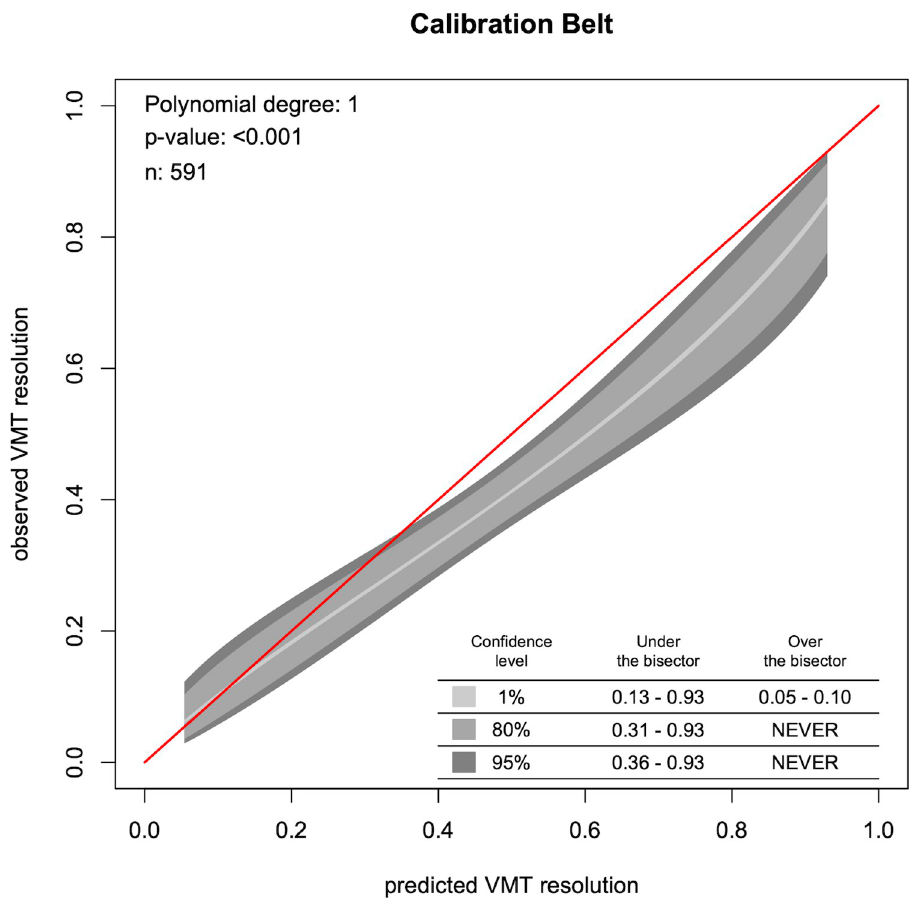
Fig 2. Calibration belt of the predicted VMT resolution by the EXPORT model and the observed VMT resolution in the current pooled patient cohort. The red line depicts a theoretical perfect correlation. The calibration belt is plotted in grey, consisting of the 95% (dark grey), 80% (grey) and 1% (light grey) confidence interval. It conveys the uncertainty in the estimated relationship between predictions and the probabilities of the true response, and was calculated using the ‘givitiR’ R package. This package utilizes a logistic regression model, based on a polynomial transformation (a linear transformation in this application), which relates the prediction of the EXPORT model to the true probabilities